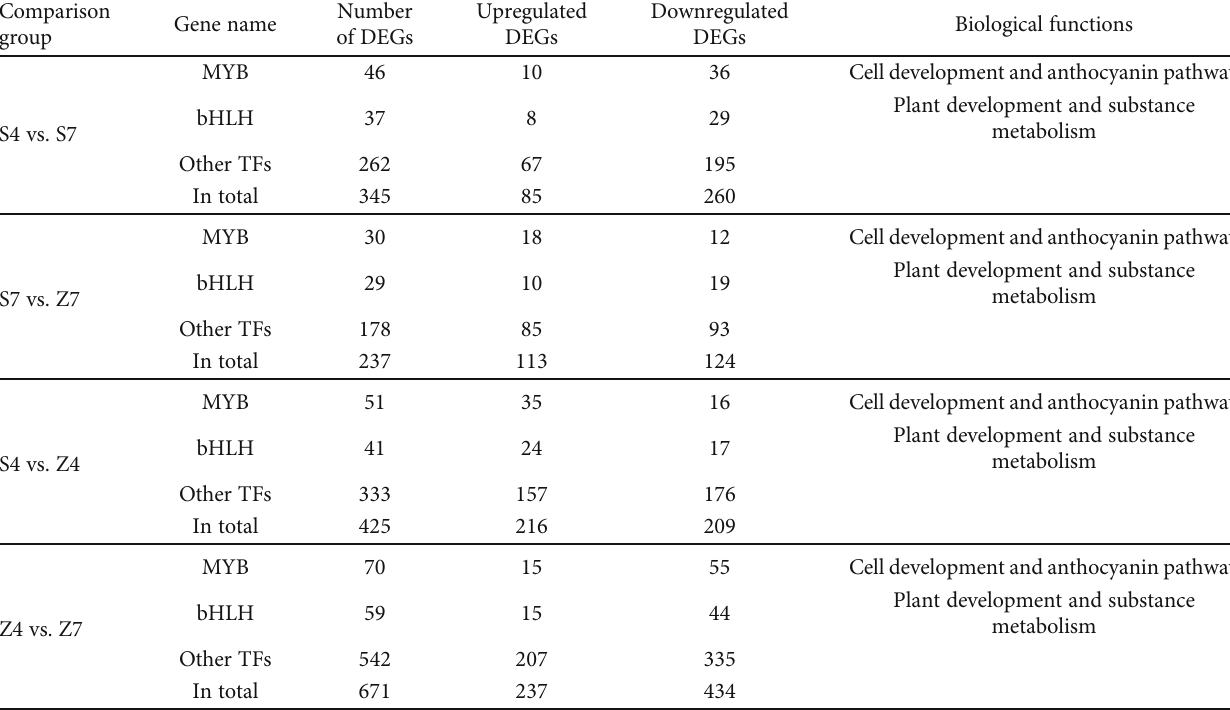
Table 2: Di ff erentially expressed transcription factors in the testa of R4 and R7 stages of Shanhua15 and Zhonghua12 peanuts. Comparison